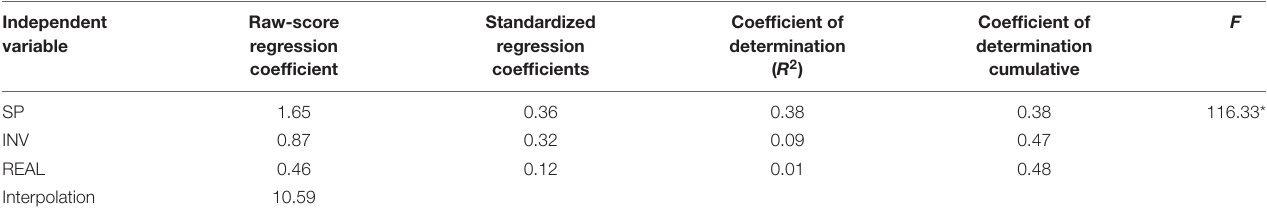
TABLE 2 | Prediction of fire safety knowledge and fire fighting